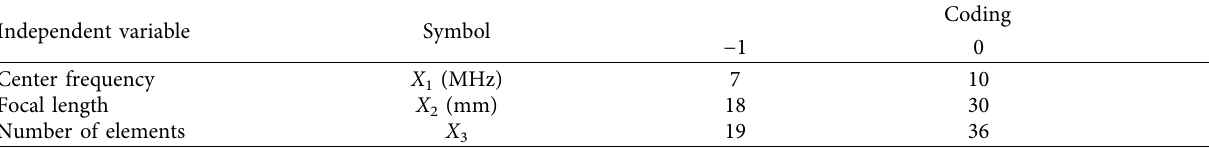
Table 5: Three-factor three-level coding.